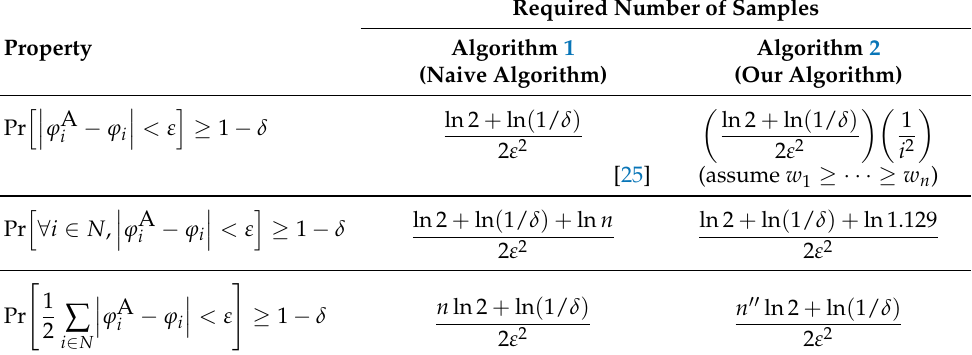
Table 1. Required Number of